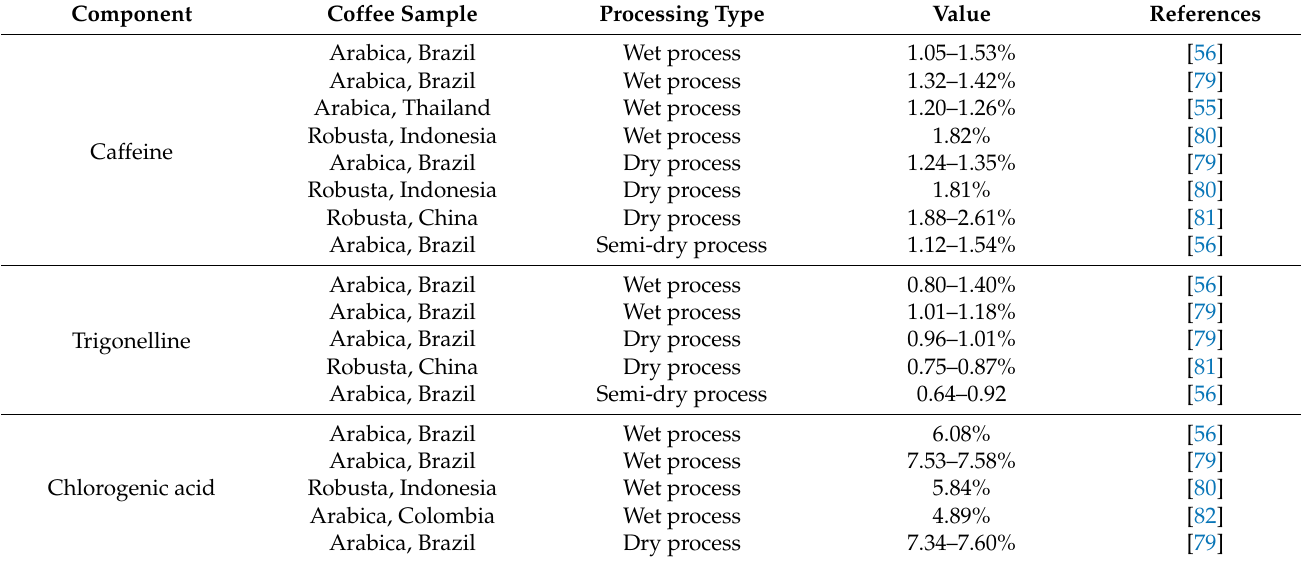
Table 1. Chemical content in various types of coffee processed in various